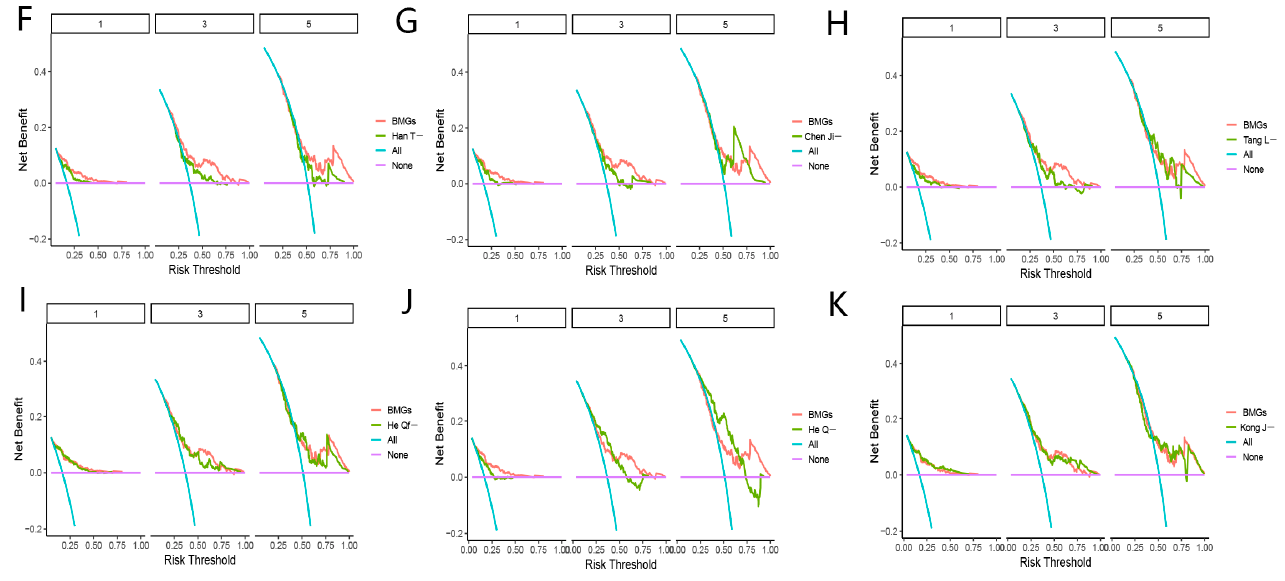
Figure 10. Comparison with other gene signatures. ( A ) C-index analyses about BMGs and 10 gene signatures in PubMed databases for prediction of the prognoses of HCC. ( B ) C-index analyses about BMGs and seven gene signatures in PubMed databases for prediction of the prognoses of HCC. ( C ) Decision curve analyses of BMGs and the Wang G-study. ( D ) Decision curve analyses of BMGs and the Peng X-study. ( E ) Decision curve analyses of BMGs and the Mou L-study. ( F ) Decision curve analyses of BMGs and the Han T-study. ( G ) Decision curve analyses of BMGs and the Chen Ji-study. ( H ) Decision curve analyses of BMGs and the Tang L-study. ( I ) Decision curve analyses of BMGs and the He Qf-study. ( J ) Decision curve analyses of BMGs and the He Q-study. ( K ) Decision curve analyses of BMGs and the Kong